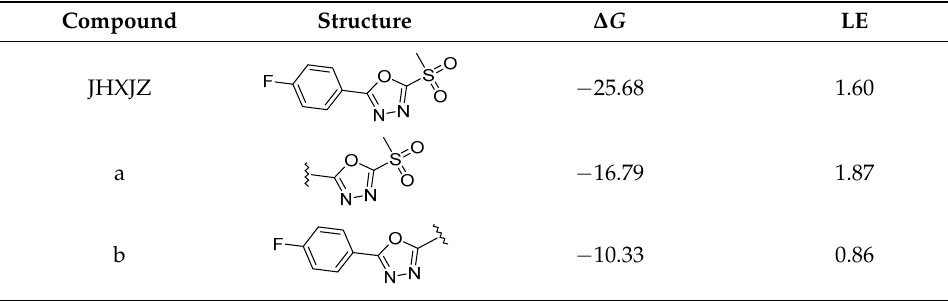
Table 1. The deconstruction analysis of JHXJZ.